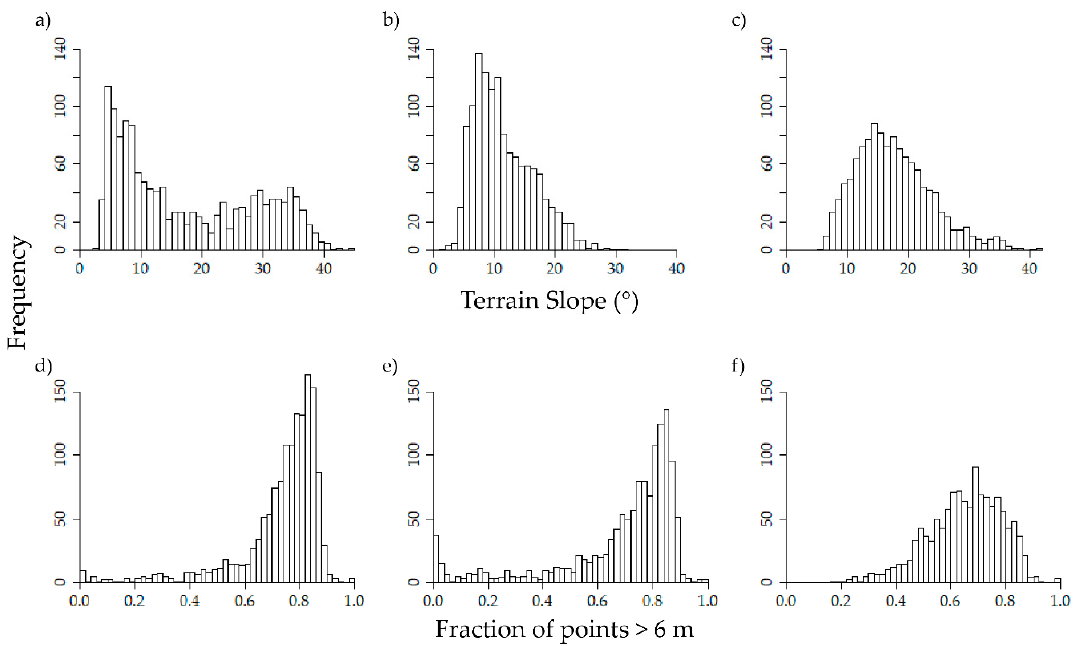
Figure 3. Distribution of area-based ALS derived terrain slope and canopy cover per study area A ( a , d ), B ( b , e ), and C ( c , f ) defined at 25 m × 25 m cell resolution.